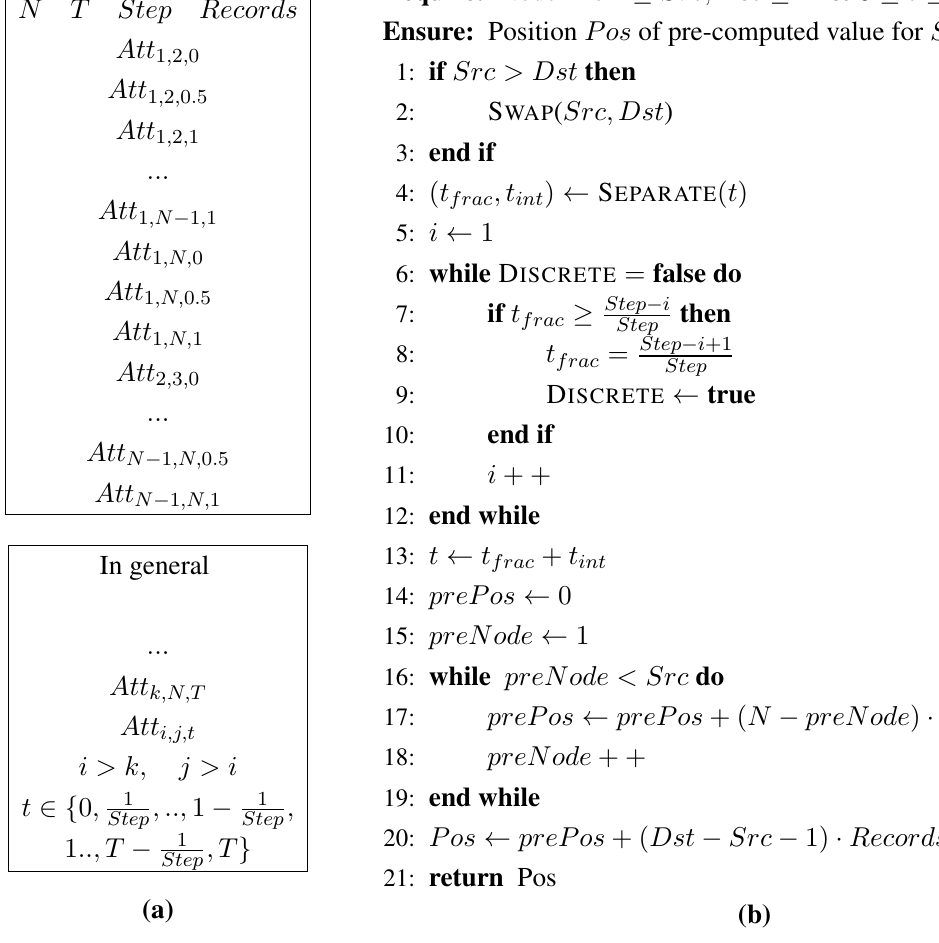
Figure 5. Pre-computed attenuation file format with its corresponding localization value algorithm used in this work. ( a ) Output format; ( b ) Position computation